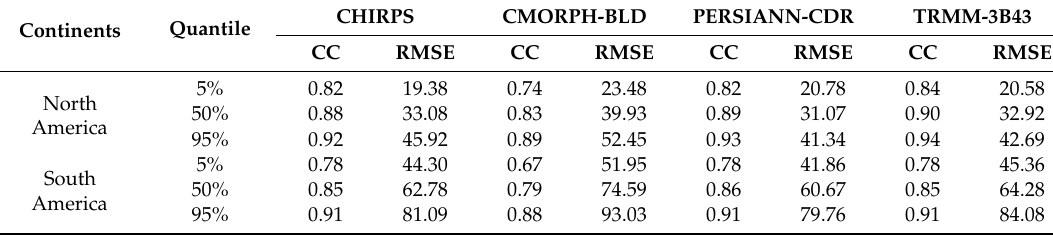
Table3. 5%, 50%, and95%quantilesofthemonthlyprecipitationCCandRMSEforsixregions2000–2016.